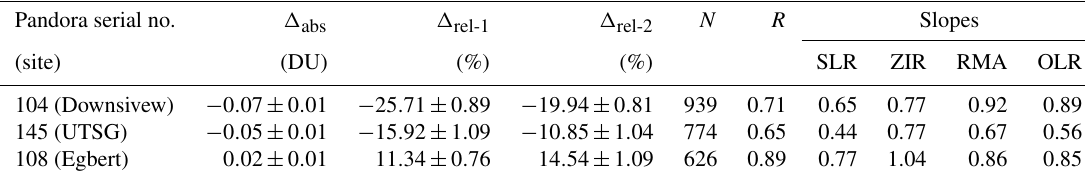
Table A3. TROPOMI KNMI vs. Pandora total column NO 2 , using the wind-based method. Pandora serial no.